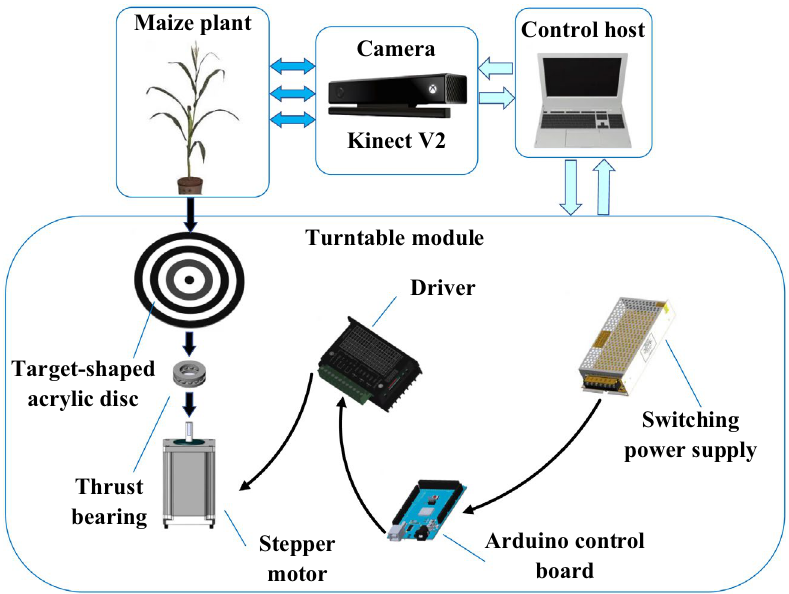
Figure 1. Schematic diagram of data collection platform.